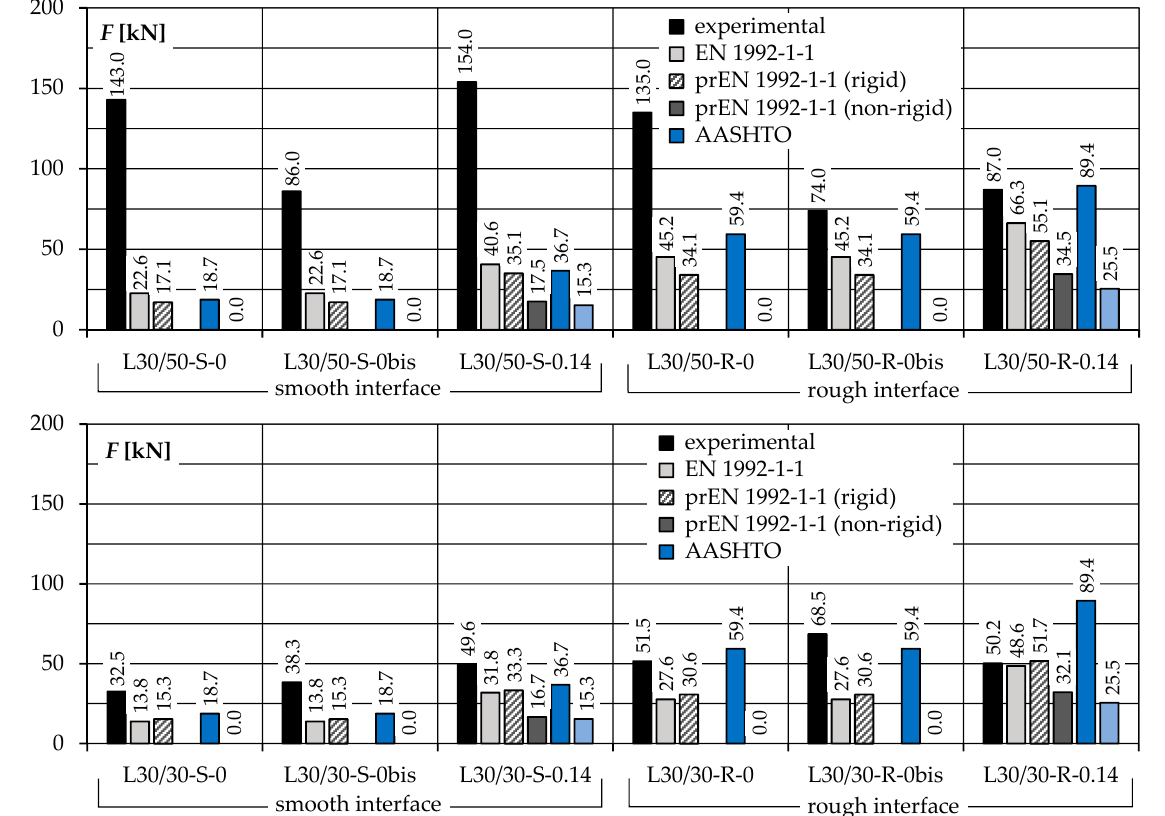
Figure 22. Comparison between experimental and predicted carrying capacities according to various design procedures.